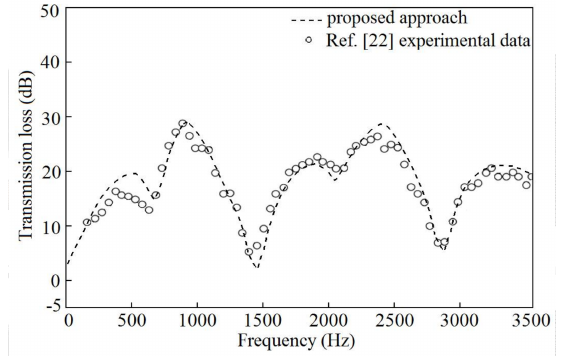
Figure 6. Comparison of the calculated and measured TL for the cross-flow silencer ( v = 17 m/s, T = 374